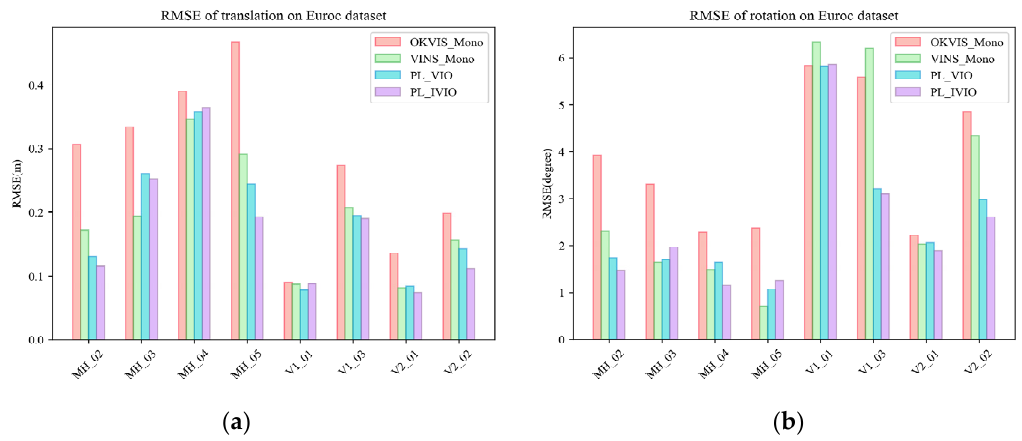
Figure 8. RMSEs for OKVIS–Mono, Vins–Mono without loop closure, PL–VIO, and the proposed IPL–VIO using the EuRoc MAV datasets. ( a ) RMSEs in translation. ( b ) RMSEs in rotation.